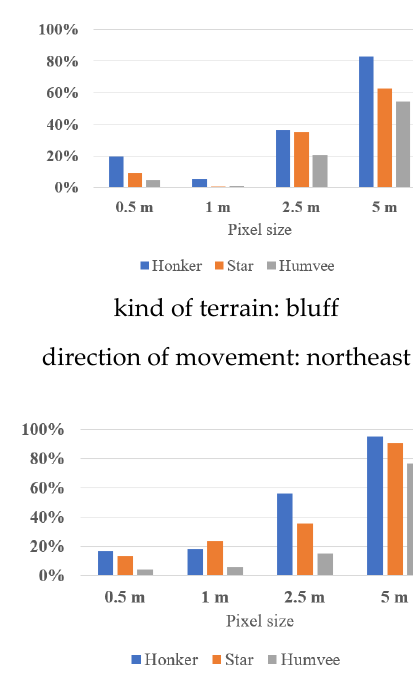
Figure 13. The comparison between high- and low-resolution elevation data: ( a ) LIDAR data (0.5 m pixel size); ( b ) digital terrain elevation data (DTED) 2 data (30 m pixel size).